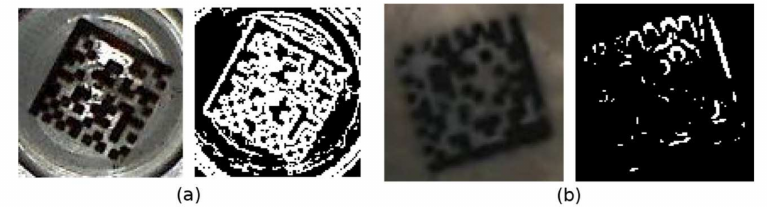
Figure 20. Edge detection problems: ( a ) Merged edges; ( b ) Missing edges.